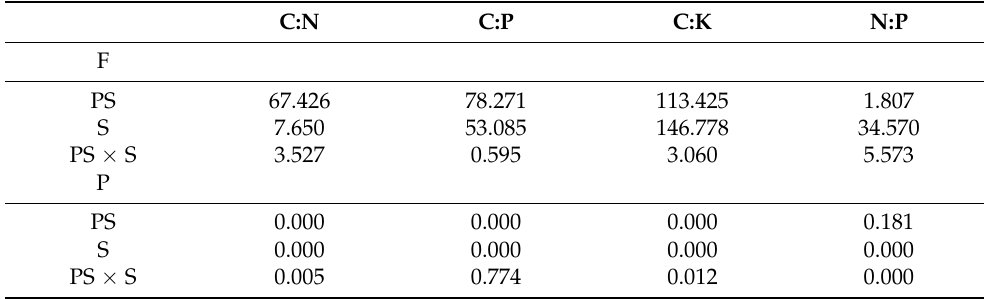
Table 2. Analysis of variance results of the C:N, C:P, C:K, N:P ratios affected by land-use type and soil